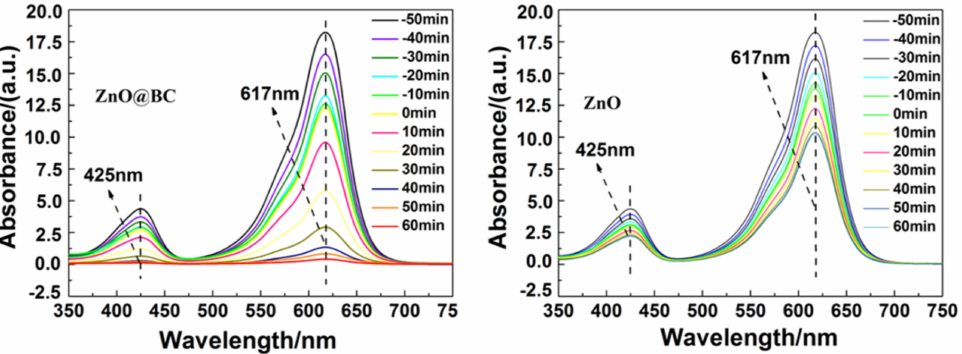
Figure 9. UV–vis absorption spectra of malachite green (MG) solution.